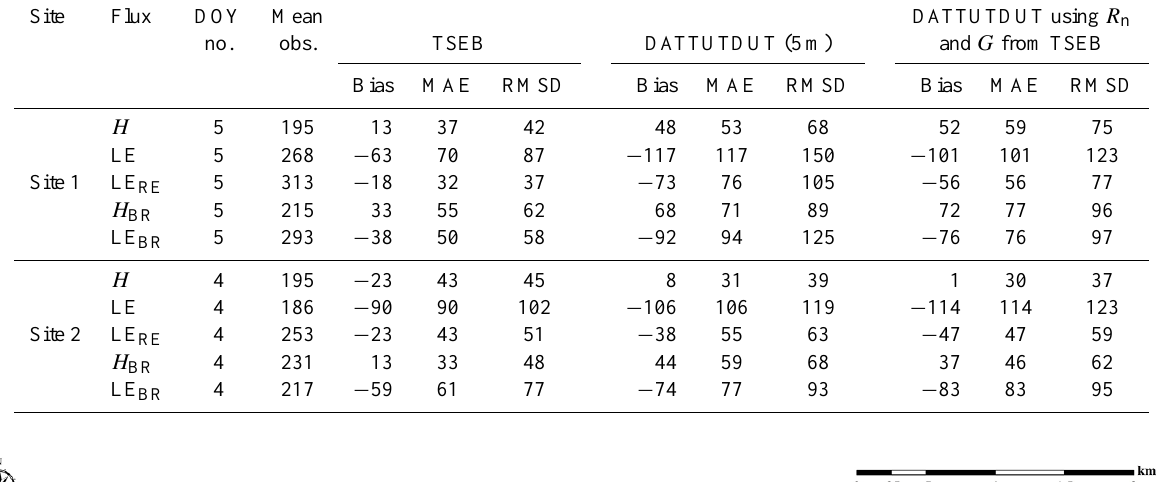
Table 5. Difference statistics comparing instantaneous output of LE from TSEB and DATTUTDUT with current DATTUTDUT algorithms for estimating the available energy versus using the estimates from TSEB.